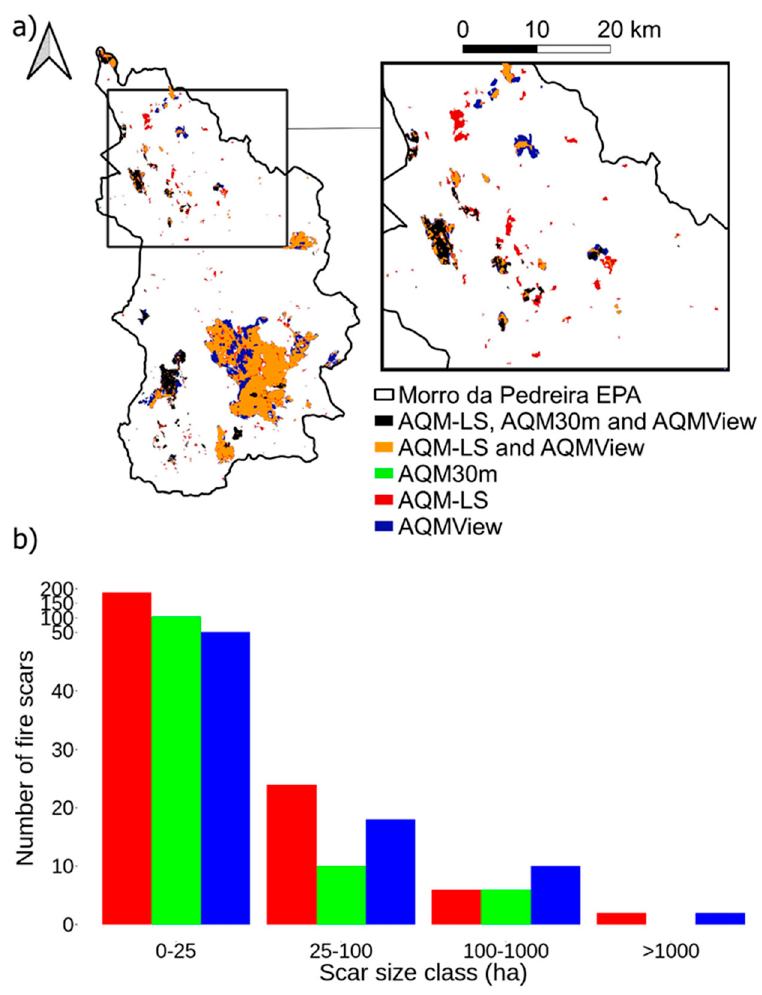
Figure 4. (a) Spatial distribution of burned area detected by AQM-LS (red), AQM30m (green), AQMView (blue), two products (namely AQM-LS and AQMView, orange), and the three products (black) in the Morro da Pedreira EPA (black outline) encompassing the Serra do Cipó NP from August 15 to November 3 2015. (b) The corresponding total number of scars detected by BA products per scar size classes.